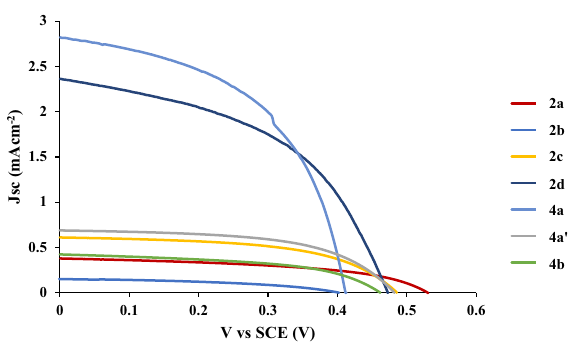
Fig. 3 Current density–voltage curves of the ensemble solar cells using different